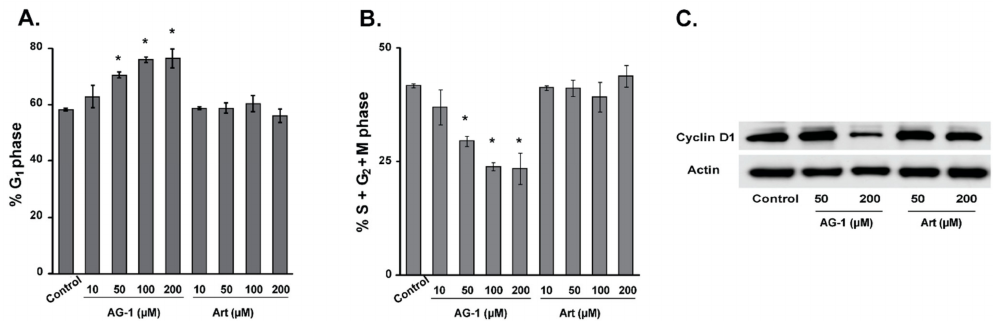
Figure 4. Artemisinin dimer (AG-1) treatment decreases cyclin D1 protein expression resulting in an increase in the percentage of cells in the G 1 -phase of the cell cycle. Exponentially growing asynchronous cultures of MB-231 cells were treated for 72 hours with 10–200 µ M of Art or AG-1. Ethanol-fixed cells were treated with RNase A and propidium iodide (PI). Flow cytometry was used to measure DNA content of cells. The percentage of cells in the ( A ) G 1 -phase and ( B ) S + G 2 + M phases was calculated using MODFIT software. Results are presented as average and standard deviation. Asterisks represent significance compared to untreated control cells; n = 3, p < 0.05. ( C ) Western blot analysis of cyclin D1 protein expression in Art- and AG-1-treated MB231